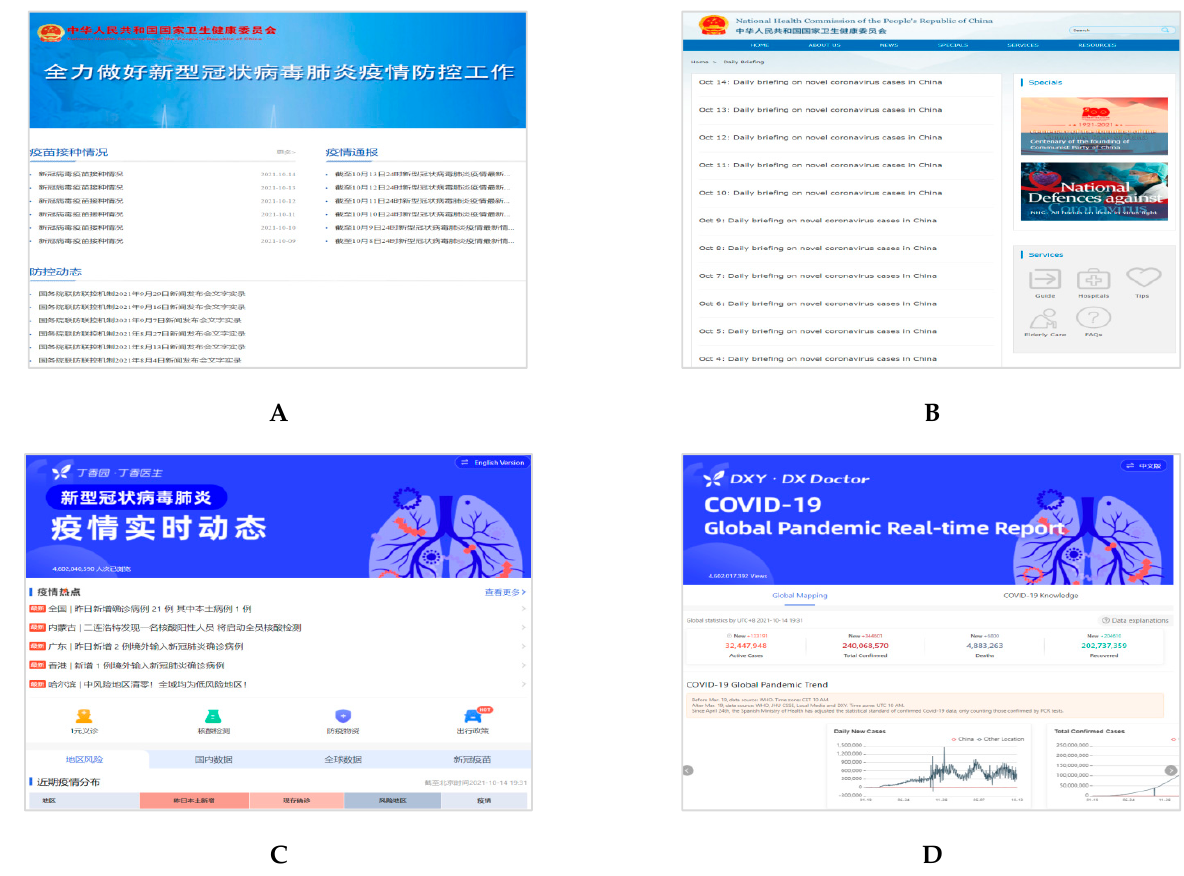
Figure 2. Homepages of the two dashboards in Chinese (left) and English (right) for China. ( A ) COVID-19 Prevention and Control. National Health Commission of the People’s Republic of China. URL: http://www.nhc.gov.cn/xcs/yqfkdt/gzbd_index.shtml (In Chinese, accessed on 14 October 2021) [42]; ( B ) Daily Briefing on Novel Coronavirus Cases in China. National Health Commission of the People’s Republic of China. URL: http://en.nhc.gov.cn/DailyBriefing.html (In English, accessed on 14 October 2021); ( C ) COVID-19 Global Pandemic Real-time Report. DXY, DX Doctor.